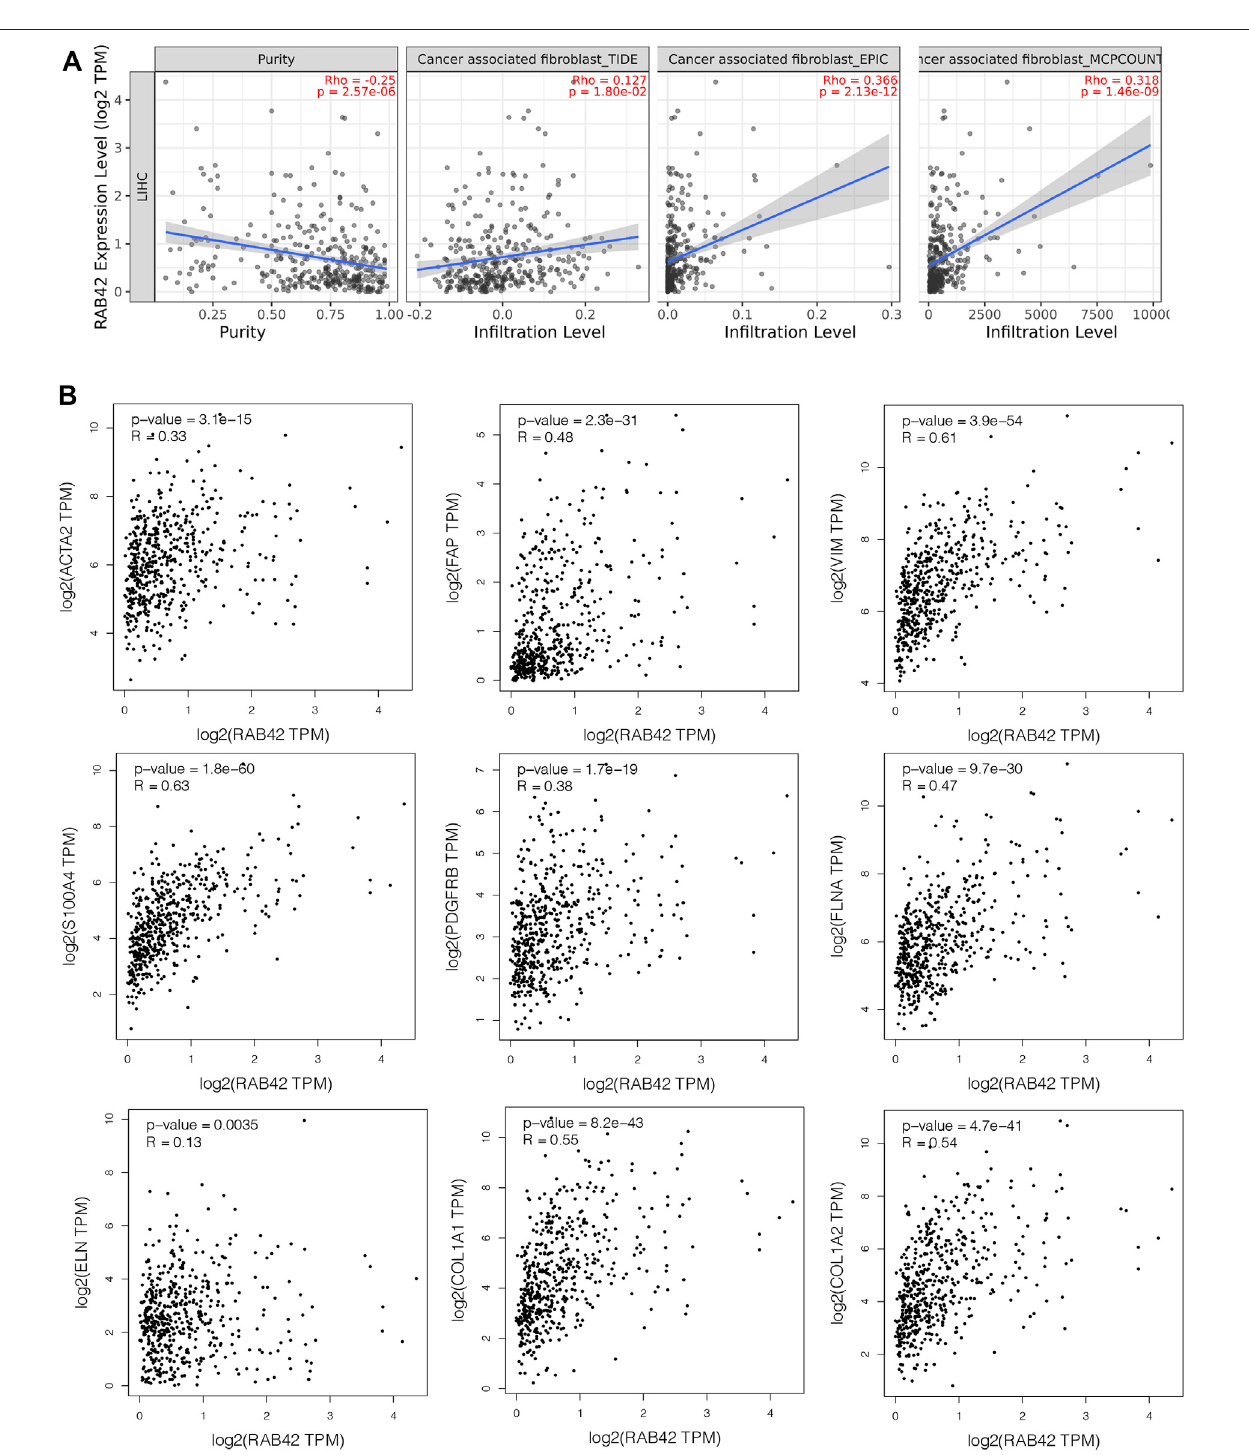
FIGURE 8 | Correlation between RAB42 expression and CAFs in HCC. (A) The association between RAB42 expression and the in fi ltration level of CAFs was investigated by using various algorithms in HCC from the TCGA. (B) RAB42 expression was positively correlated with several markers of CAFs (ACTA2, FAP, VIM, S100A4, PDGFRB) and ECM-related genes (ELN, FLNA, COL1A1, COL1A2) based on GEPIA database. CAFs, cancer-associated fi broblasts; ECM, extracellular matrix.